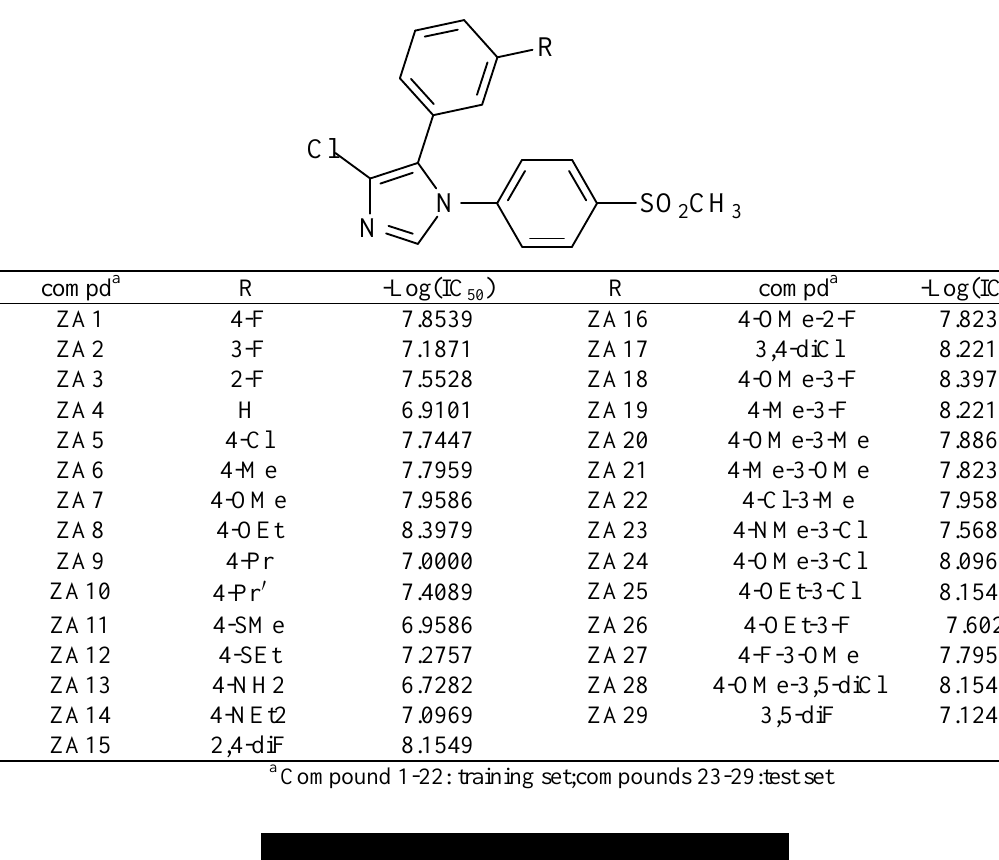
Table 1. Chemical structures and corresponding biological activities of 1,5-Diarylimidazoles